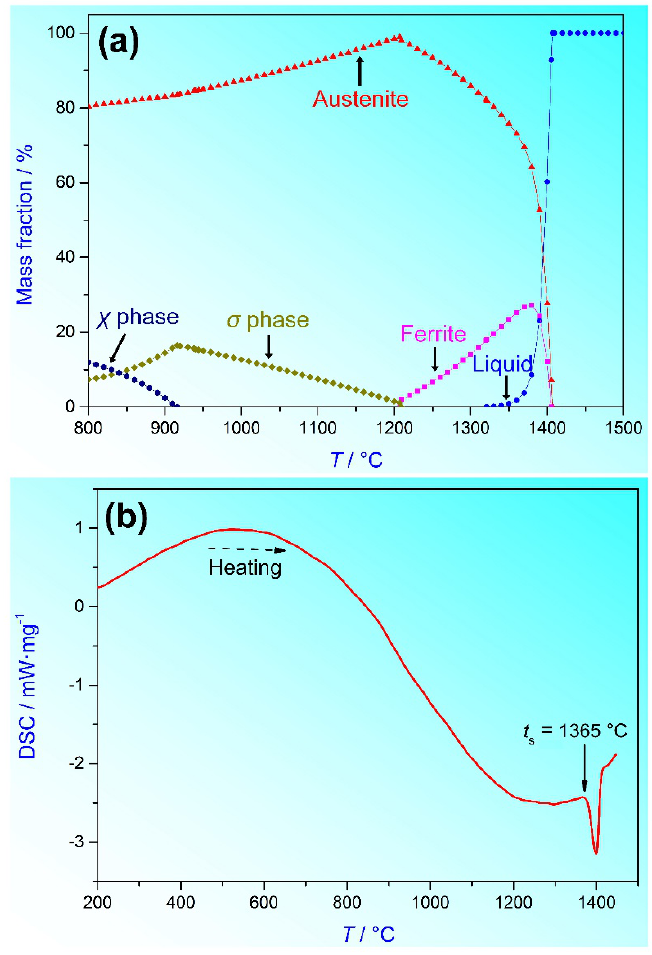
Figure 11. The equilibrium phase composition of the experimental steel in the temperature range of 800–1500 °C ( a ) and the curve of DSC test ( b ).